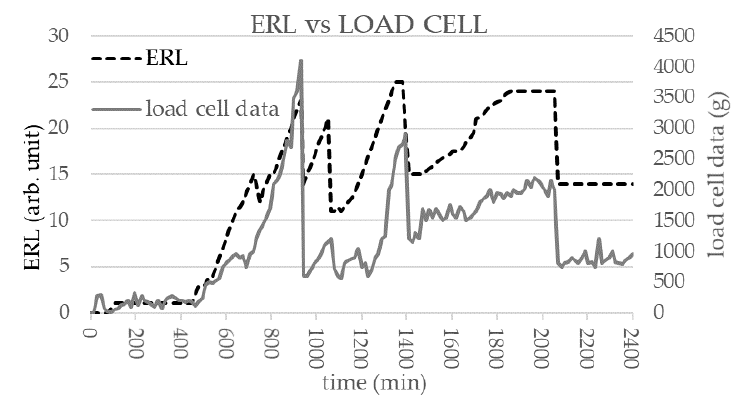
Figure 9. ERL and load cell data of the reference sample versus time during a snow event. Table 5. Rcov index for the tested samples during the snowfall events. n.a data are not available.